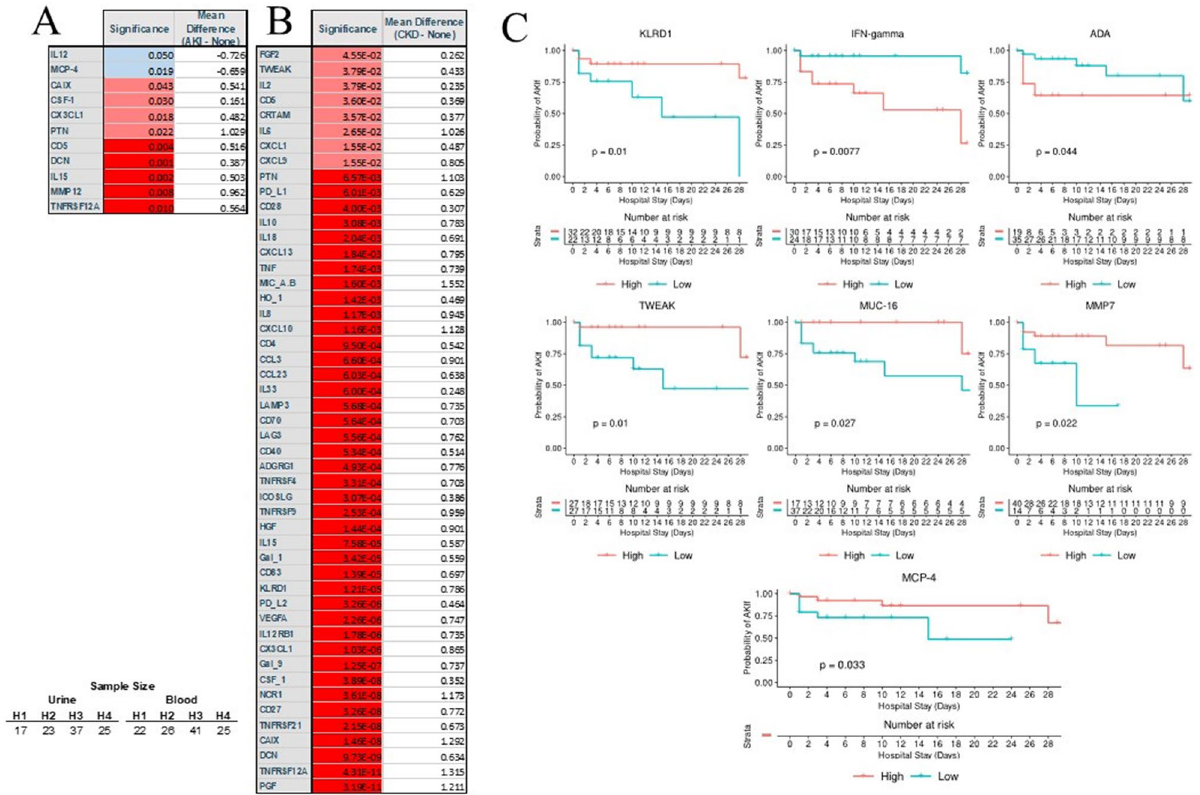
Figure 6. AKI was signified by several markers of injury in urine ( A ) but preexisting renal disease induced much more significant changes in urine markers ( B ). Several markers were good predictors of the emergence of AKI over the course of COVID-19 ( C